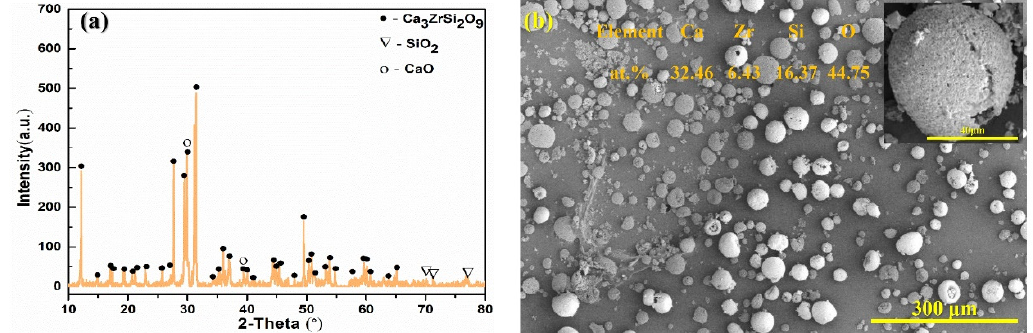
Figure 2. XRD pattern ( a ) and SEM morphologies ( b ) of CZSO powder after spray-drying.